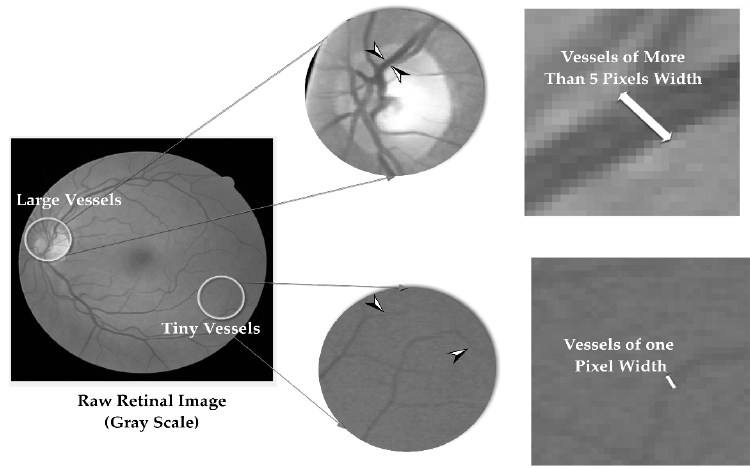
Figure 4. Pixel width variation of retinal vessels (in pixels).